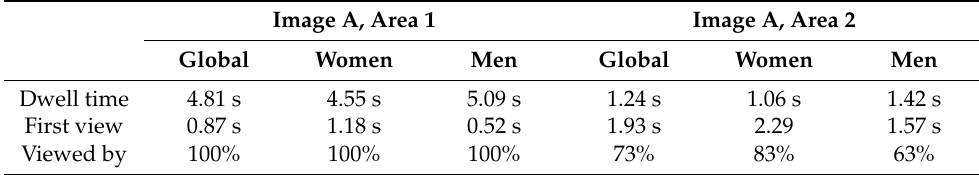
Table 3. Gender analysis. Image A.